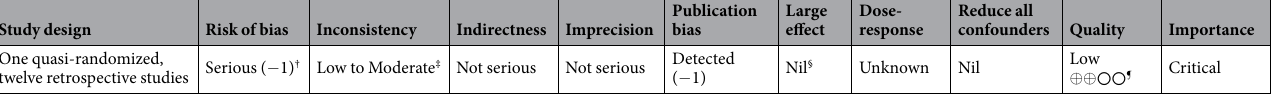
Table 3. GRADE assessment. † Lack of randomization, blinding, allocation concealment, intention-to-treat analysis. ‡ I 2 = 35%, p = 0.102 (I 2 < 40% may be low; 30–60% may be moderate; 50–90% may be substantial; 75–100% may be considerable). § Odds ratio < 2 (95% CI 1.21, 2.36). ¶ This research provides some indication of the likely effect. However, the likelihood that it will be substantially different (a large enough difference that it might have an effect on a decision) is